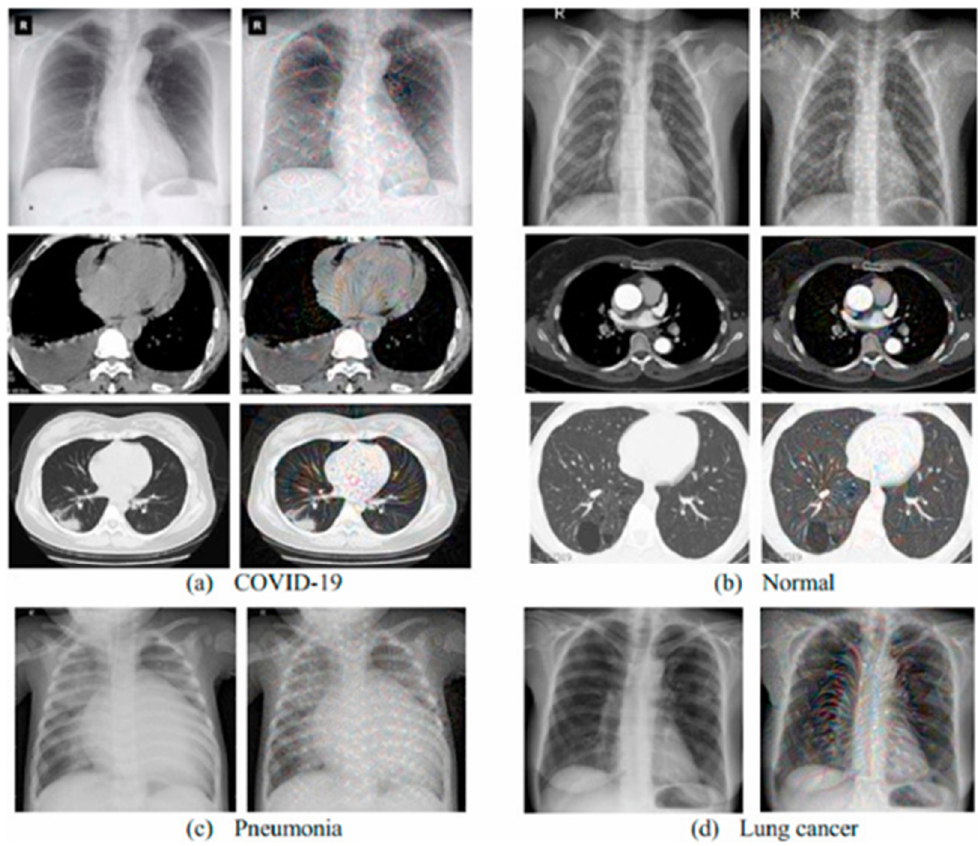
Figure 4. CT and X-ray Medical Images utilized for Diagnosing COVID-19 and distinguishing from other diseases (Ramdani et al., 2021) . Figure 4a,b shows CT images of COVID-19 of normal patient, while Figure 4c,d shows CXR images of Pneumonia and lung cancer.